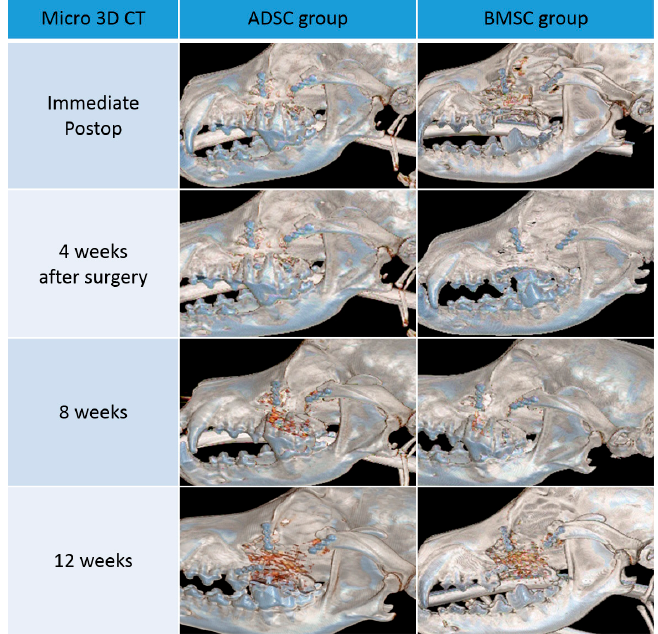
Figure 6. Three-dimensional (3D) computed tomography (CT) images of the adipose-derived stem cell (ADSC) and bone marrow stem cell (BMSC) groups. Images were acquired directly after surgery and 4, 8, and 12 weeks later.